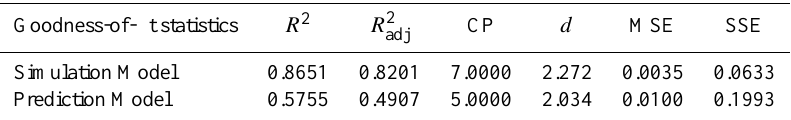
Table 2. Values of the goodness-of-fit statistics (coefficient of multiple determination, – R 2 –, adjusted R 2 ,– R 2 Watson, d , sum square error, SSE, and the mean square error, MSE) for simulation and prediction chestnut productivity multiple regression